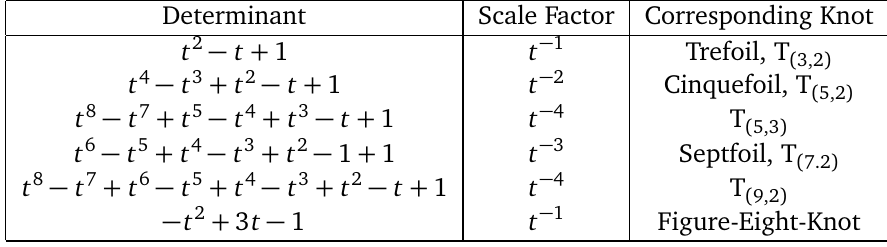
Table 2: Alexander polynomials for a few different exceptional structures. The left column is what comes out from inspection of the Fermi surface, using the algorithm mentioned in Section 3.2.2, while the middle column is the is the factor which is to multiply the determinant in order to obtain the correctly scaled Alexander polyno- mial. Only by considering the Fermi surface, the topology of the knotted structures can be determined. Determinant Scale Factor Corresponding Knot t 2 − t + 1 t − 1 Trefoil, T ( 3,2 ) Cinquefoil, T ( 5,2 )